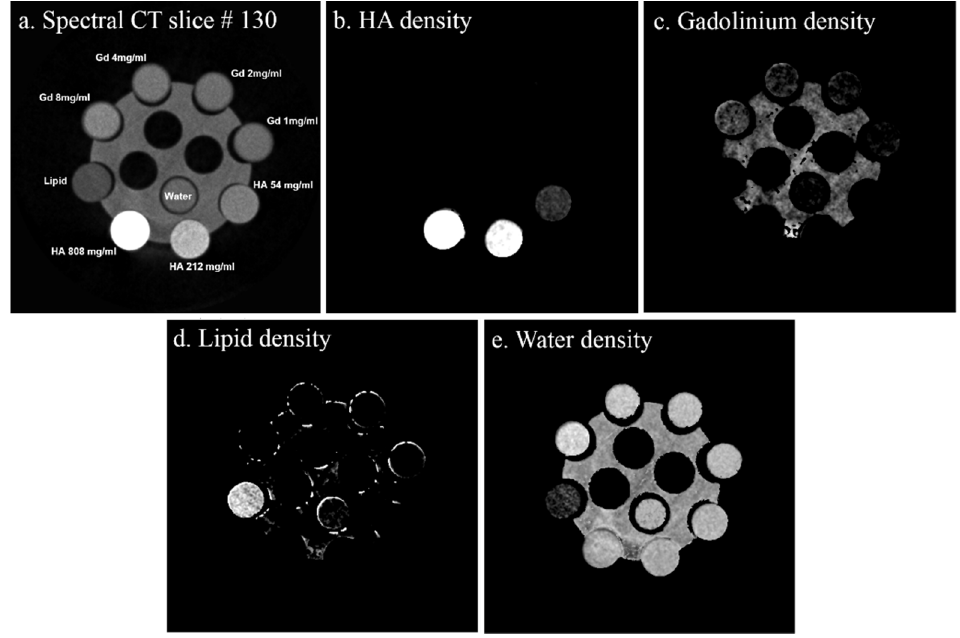
Figure 9. Identification of spectral CT image into individual elements using protocol ‐ 2. Top ( a – c ): spectral CT image with one of the energy bins (27–33 keV), image with only HA density, and image with only gadolinium density. Bottom ( d , e ): image with lipid density and image with only water density. The window levels are normalized from 0 to 1 for display.